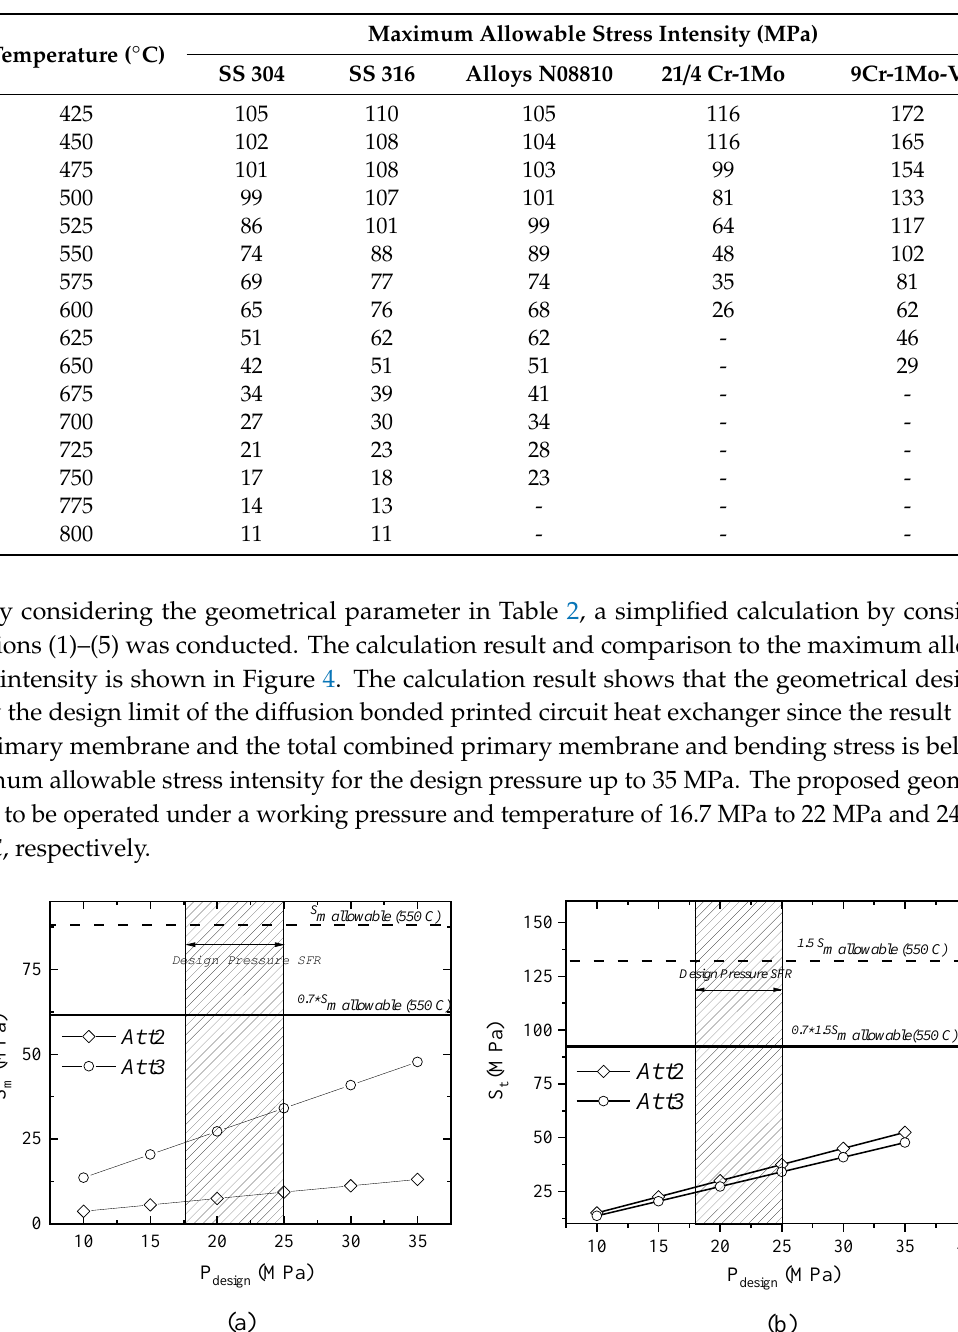
Table 3. Maximum allowable stress intensity for a di ff erent type of material.